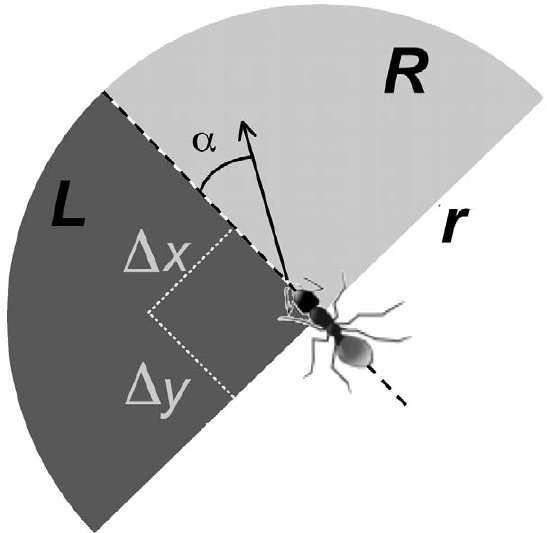
Figure 4. Regions used for estimating the concentrations of pheromone around the ant. For each tracking event we get the position of the ant at time t and its direction at times immediately prior to or after t (average directions during 0 : 4s intervals). The angle a is the change from previous direction. L and R are the integrals of all pheromone in two circular sectors ahead of the ant on the left and right side, respectively. In order to avoid spurious correlations between ant movement and the pheromone added by the ant during that same movement, we always calculate correlations with the pheromone map as it was 16 seconds before the tracking event ( tmap ~ t 16